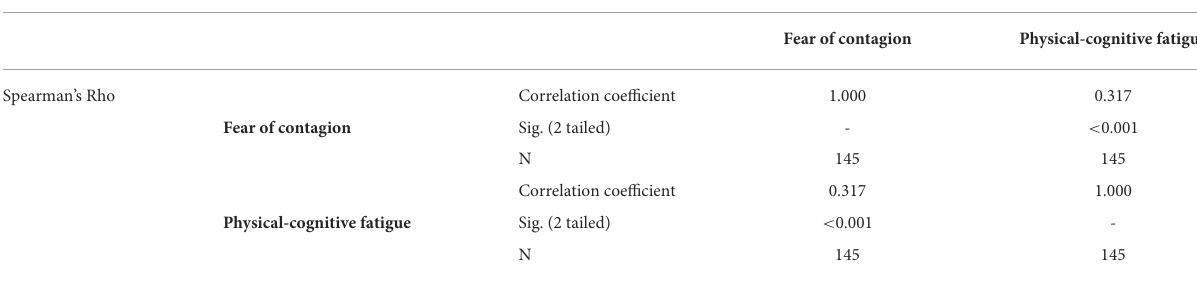
TABLE 3 Correlation matrix: generalized anxiety and physical-cognitive